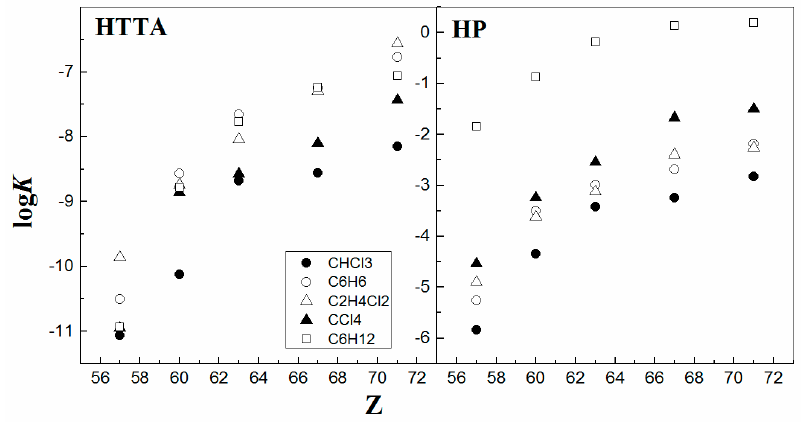
Figure 5. Log K vs. Z. Data from Refs. [6–8,12].